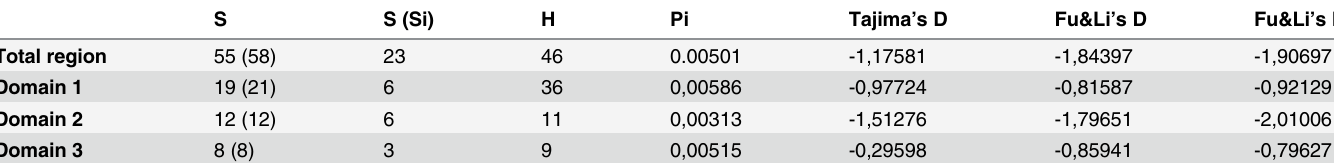
Table 2. Summary of sequence analysis for 52 PkAMA1 genes and tests for departure from